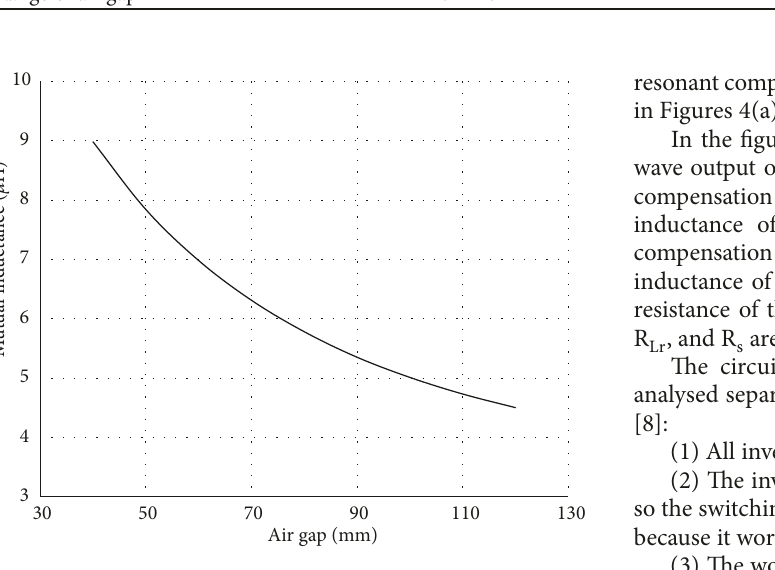
Figure 3: Mutual inductance